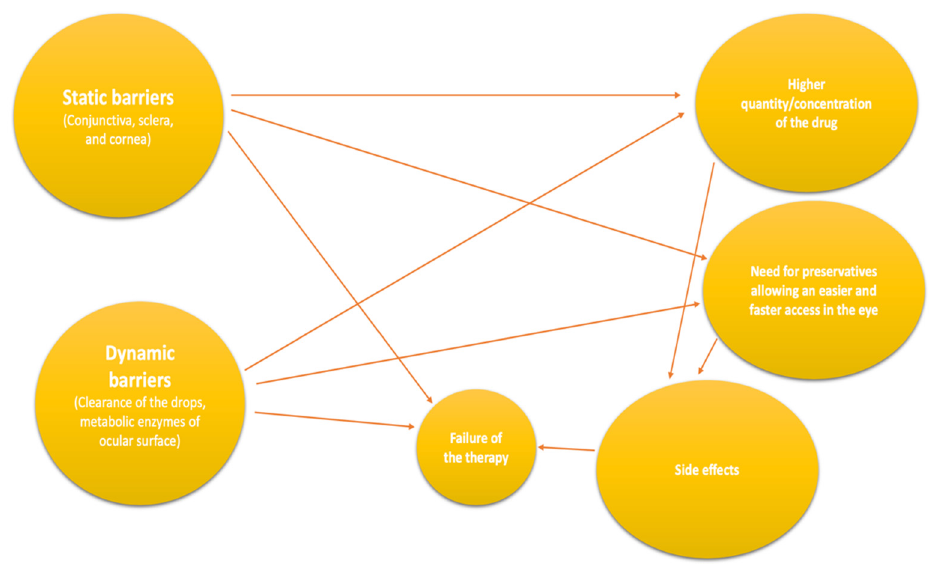
Figure 1. Causes of therapy